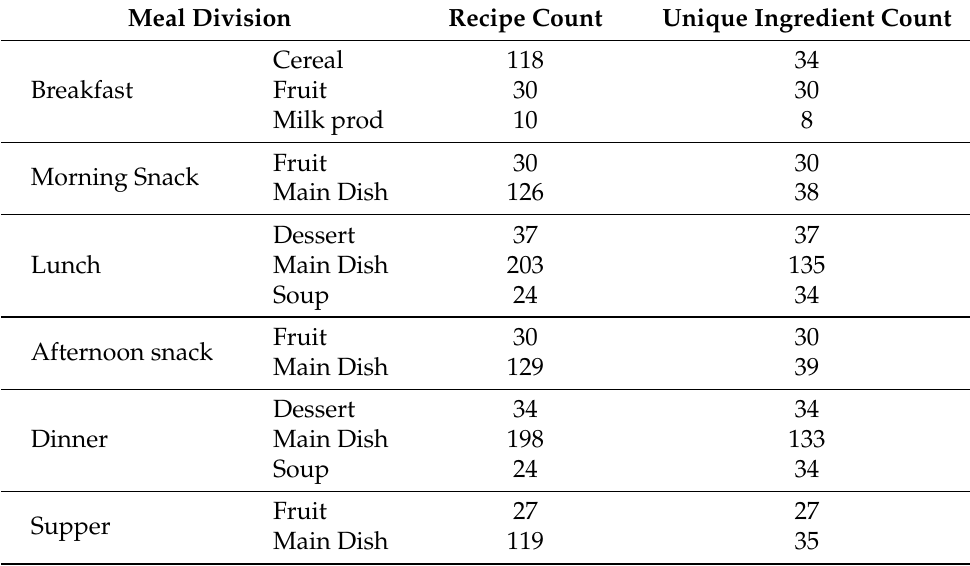
Table 2. Number of recipes and unique ingredients per meal division. Meal